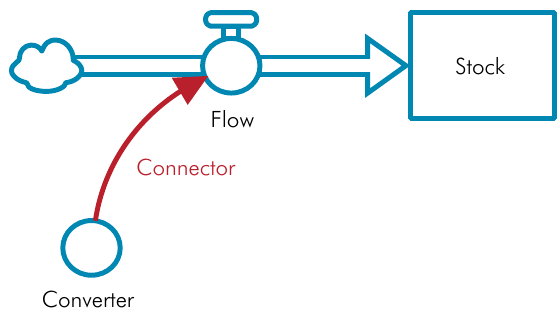
Figure 1. Basic components of one representative stock and flow diagram of System Dynamics model.